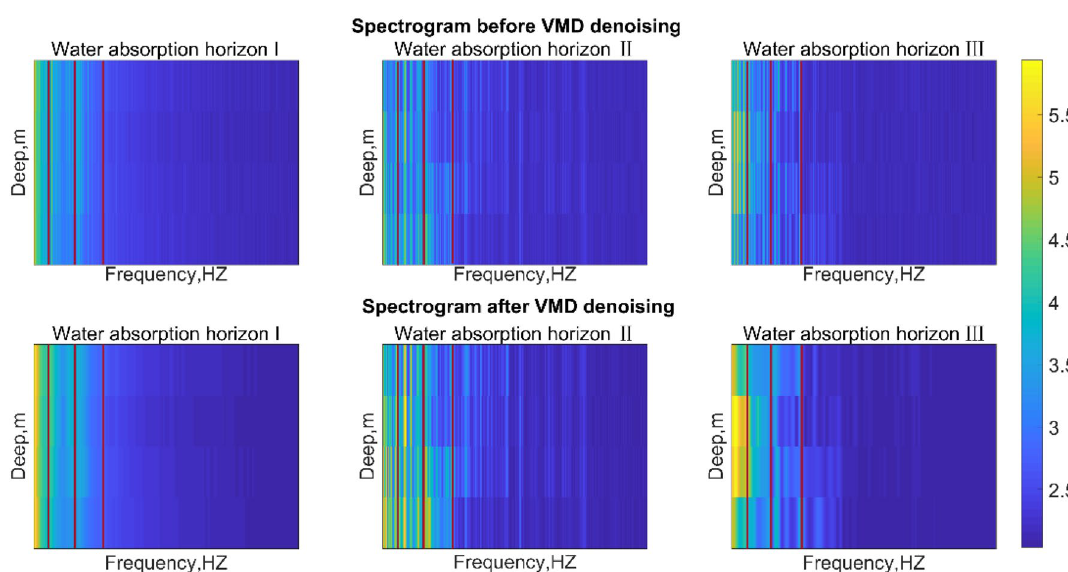
Fig. 6 Spectrogram of different water absorption